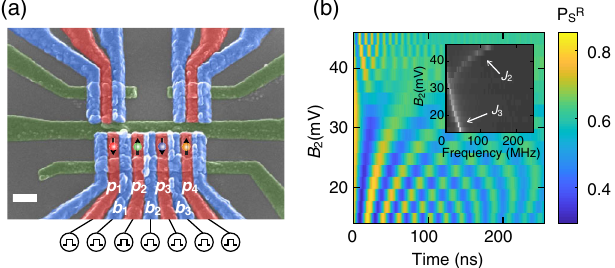
FIG. 1. (a) Scanning electron micrograph of the quadruple quantum-dot device. The scale bar is 200 nm. (b) Measured exchange oscillations with virtual barrier gate B 3 ¼ 30 mV. Inset: Absolute value of the fast Fourier transform (FFT) of data shown in panel (b). As B 2 increases, J 3 decreases. P S R is the singlet return probability of the right